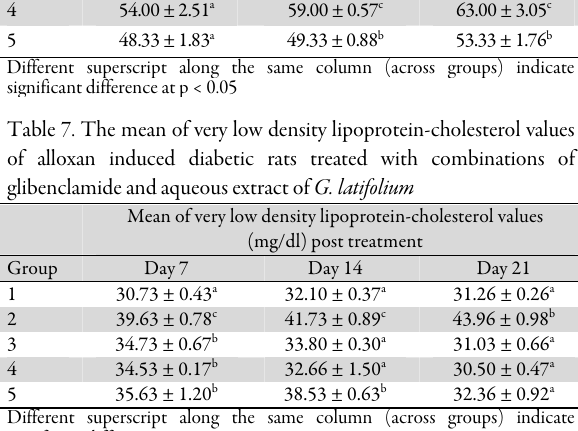
significant difference at p < 0.05 Table 9. The mean of reduced glutathione values of alloxan induced diabetic rats treated with combinations of glibenclamide and aqueous extract of G. latifolium